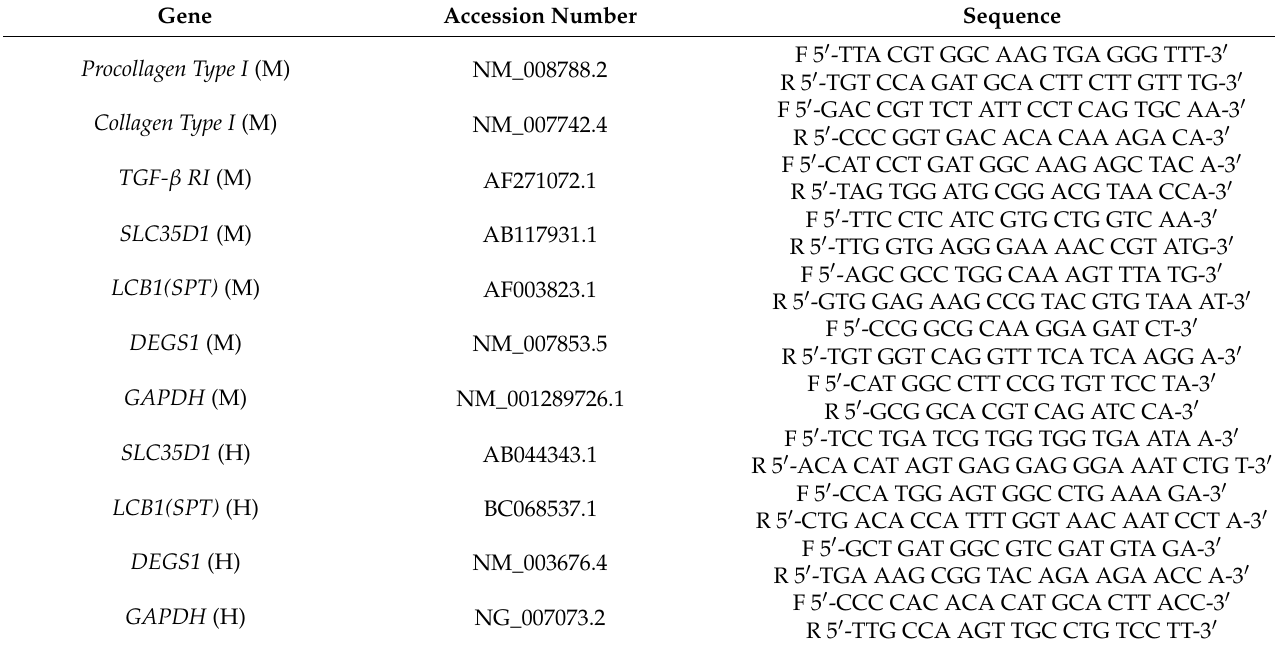
Table 1. Primer sets used for real-time